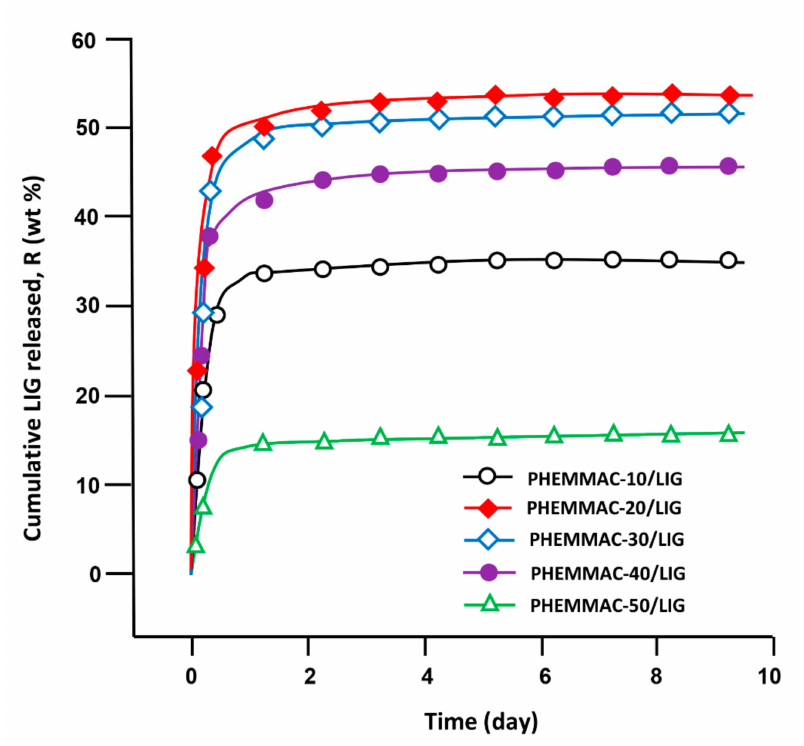
Figure 12. Cumulative LIG released from the PHEMMAC drug-carrier